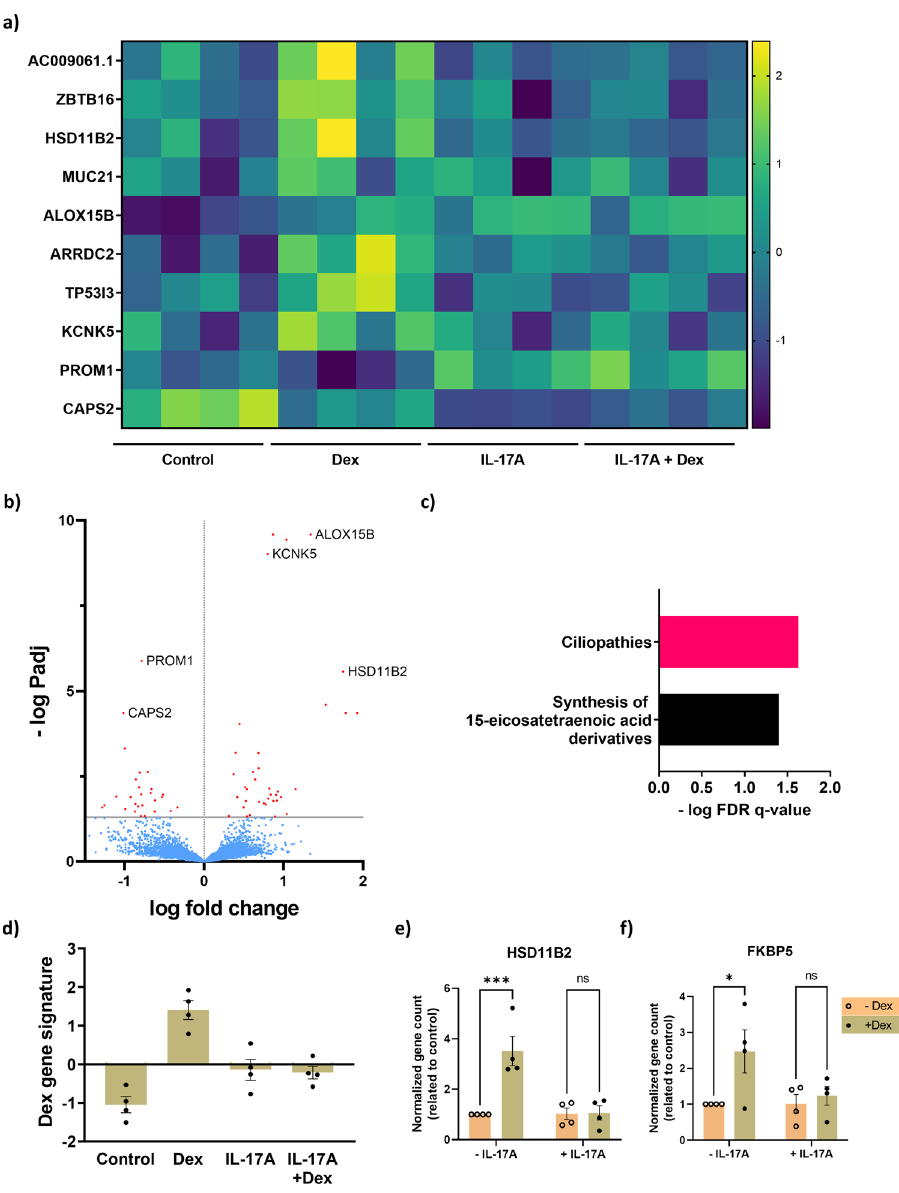
Figure 3. Dexamethasone (Dex)-inducible genes are dampened by the presence of IL-17A in human airway epithelial cells (hAECs). hAECs were cultured and differentiated at an air liquid interface (ALI) and exposed to IL-17A (10 ng/ml) with or dexamethasone (10 nM) for 14 days. Gene expression was determined by bulk RNA sequencing and differentially expressed genes were analyzed and presented as a heatmap of the top 10 most regulated genes by dexamethasone, with each column in the groups representing an individual donor ( a ) and by a volcano plot ( b ). Pathway analysis (GSEA) of the differentially expressed genes was done subsequently ( c ). The dexamethasone gene signature was calculated as Z-score ratio of the most regulated genes ( d ). Canonical corticosteroid gene expression, HSD11B2 ( e ) and FKBP5 ( f ), were analyzed from normalized gene counts. Data represent means ± SEM. N = 4 donors. Statistical analyses were performed with paired two-way ANOVA and Šidák’s multiple comparison test, *p < 0.05, ***p <